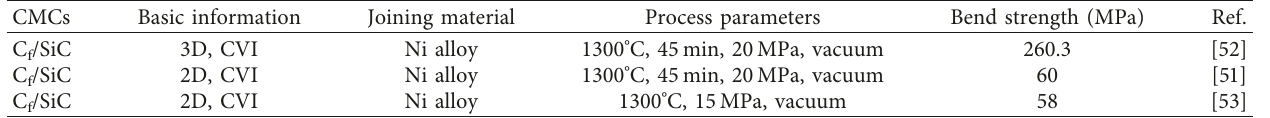
Table 4: Self-joining of C f /SiC composites with high-temperature